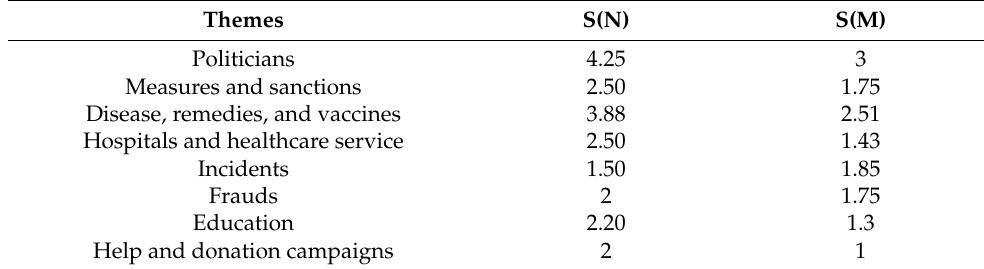
Table 3. Number of sources used to fact-checking of each